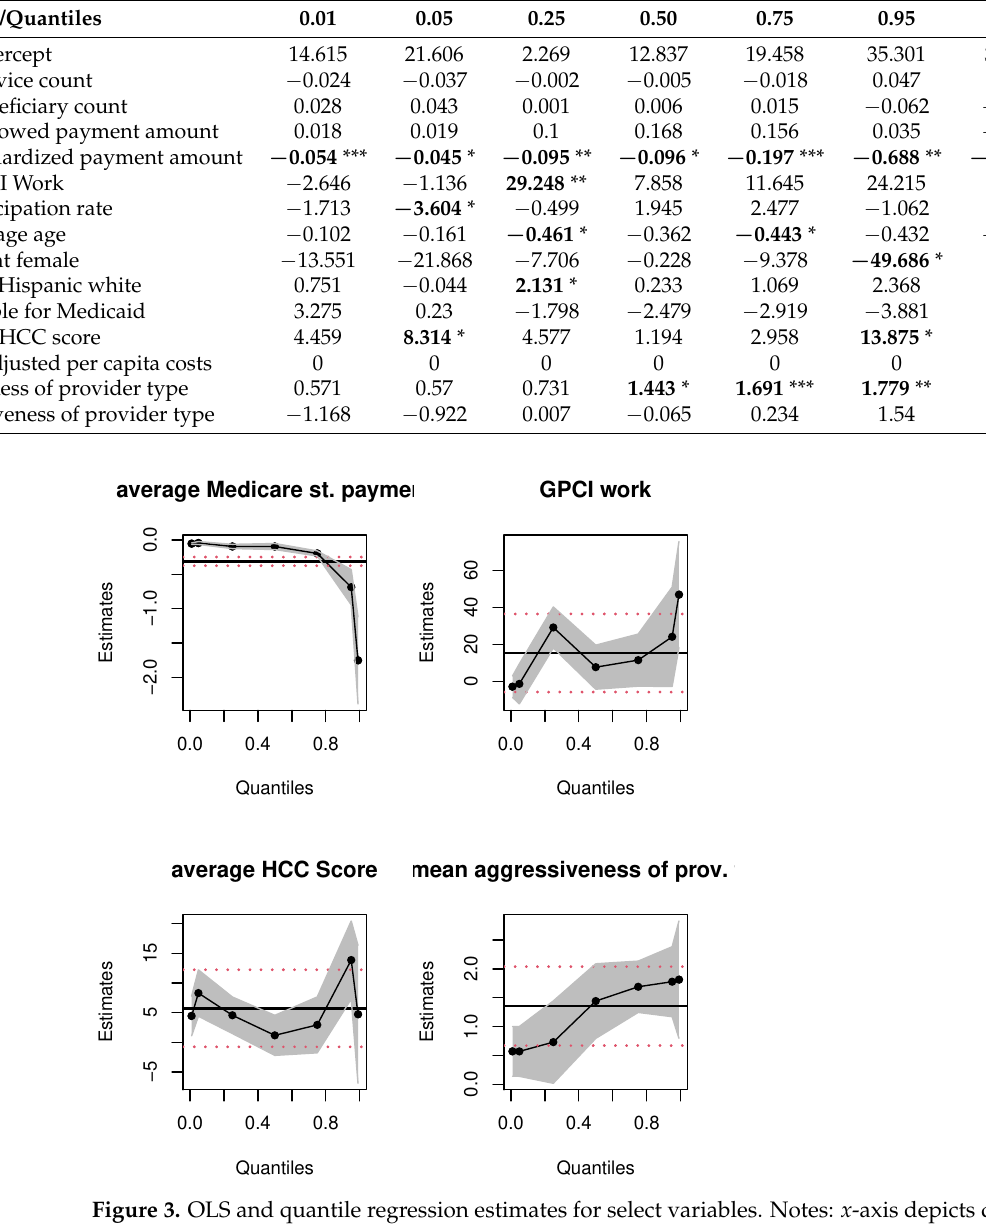
Table 3. Quantile regression coefficient estimates for each variable for the percentiles of {0.01, 0.05, 0.25, 0.5, 0.75, 0.95, 0.99}